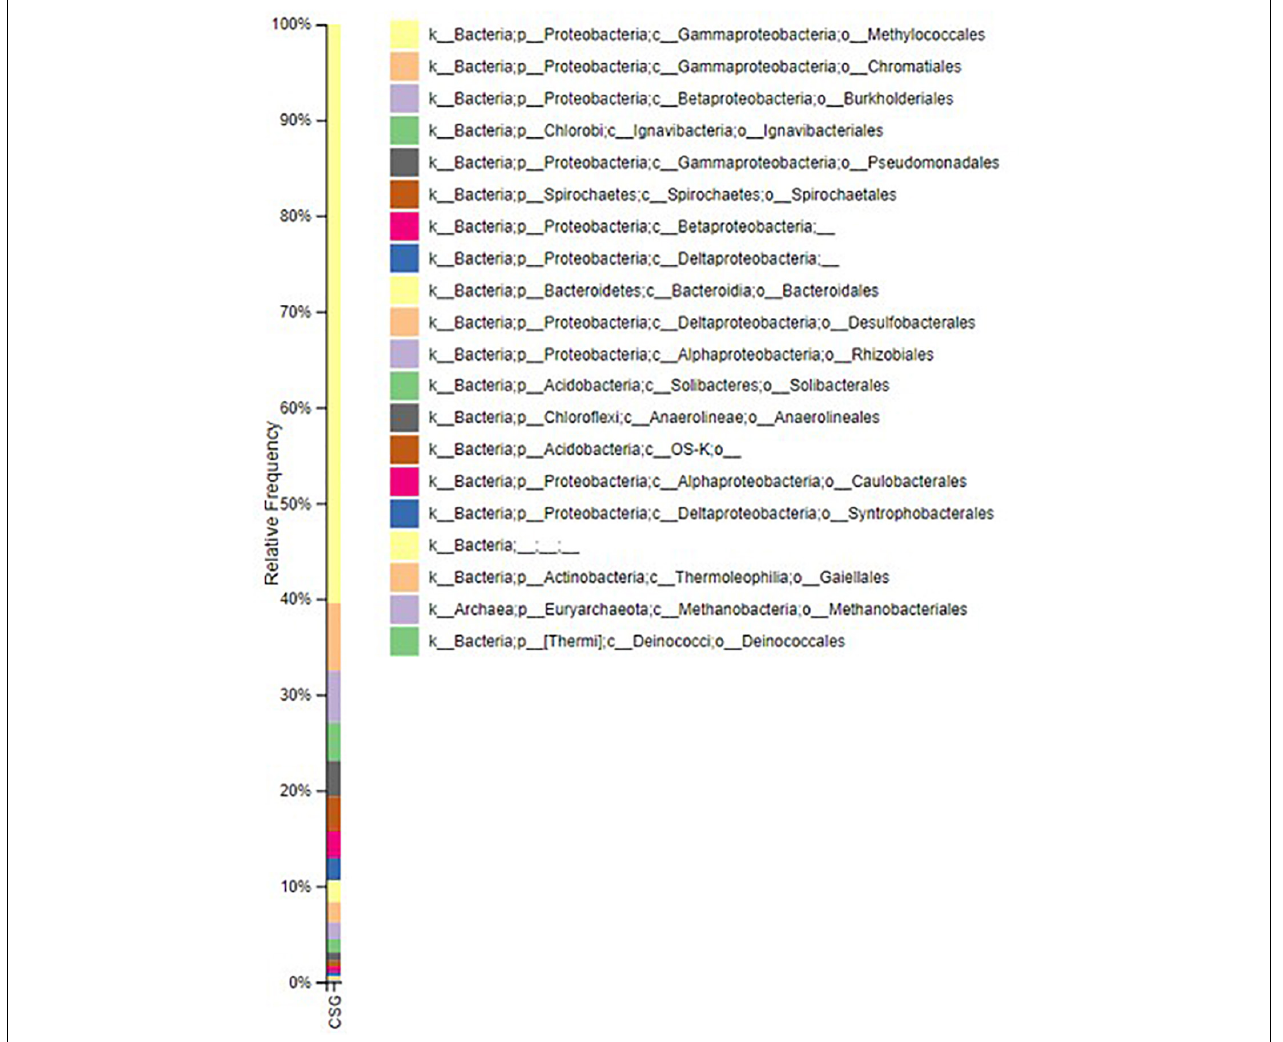
FIGURE 3 | Relative abundance of microbial communities present in the groundwater. The image is generated by using QIIME 2 VIEW